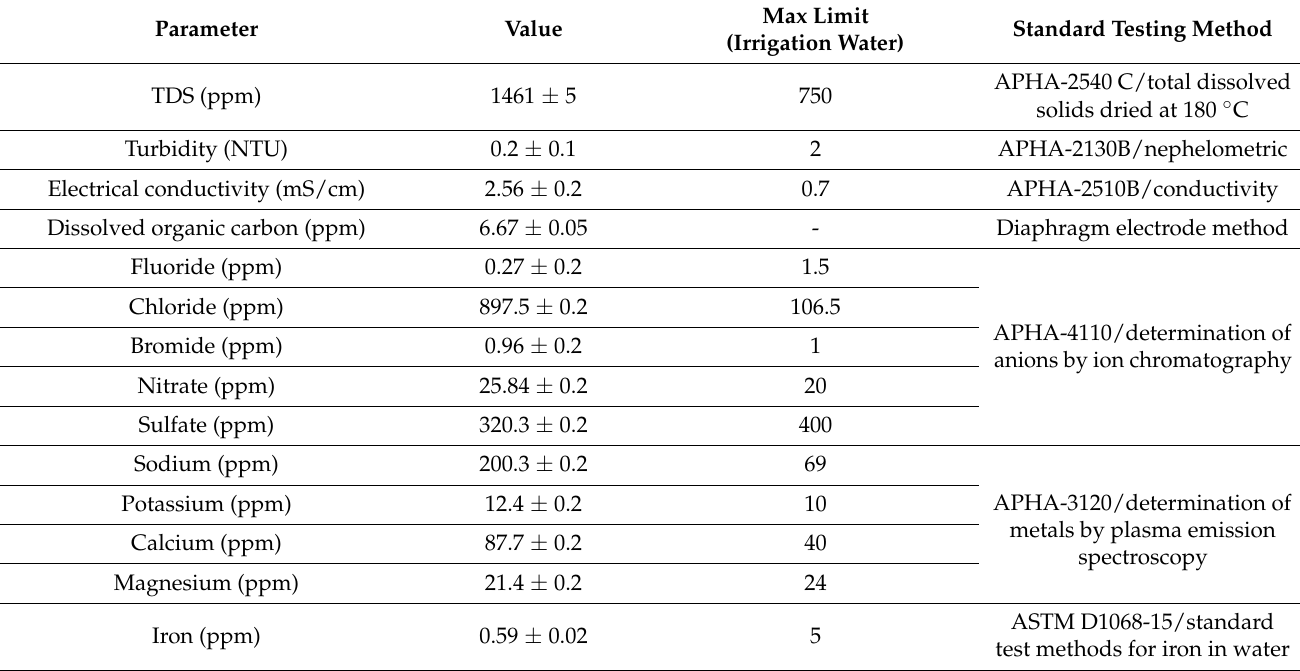
Table 1. Characteristics of the feed water (treated municipal sewage